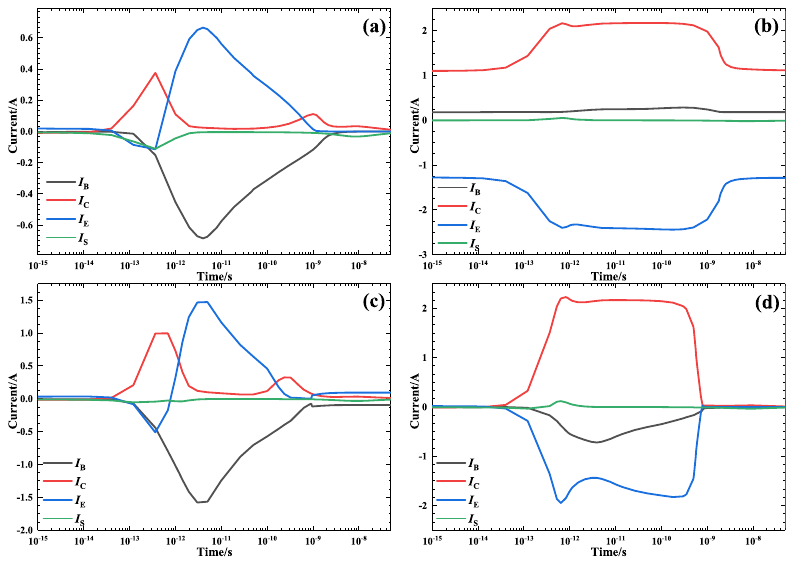
Figure 14. Change in current with time when heavy ions vertically irradiate the emitter of the SiGe HBT under the substrate inverse bias ( a ), positive bias ( b ), off bias ( c ) and collector positive bias ( d )